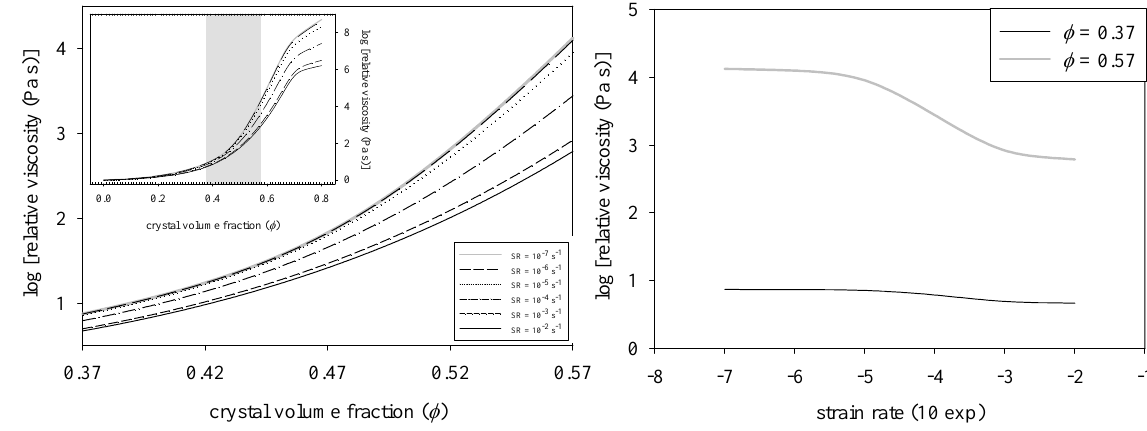
Fig. 4. (a) Relative viscosity as a function of crystal volume fraction at different strain-rates; (b) relative viscosity as a function of strain- rate for two crystal volume fractions of 0.37 and 0.57, adopted for the fire-fountain and the Strombolian phases of the Etna 2000 activity, respectively. Calculations made with the model in Costa et al.